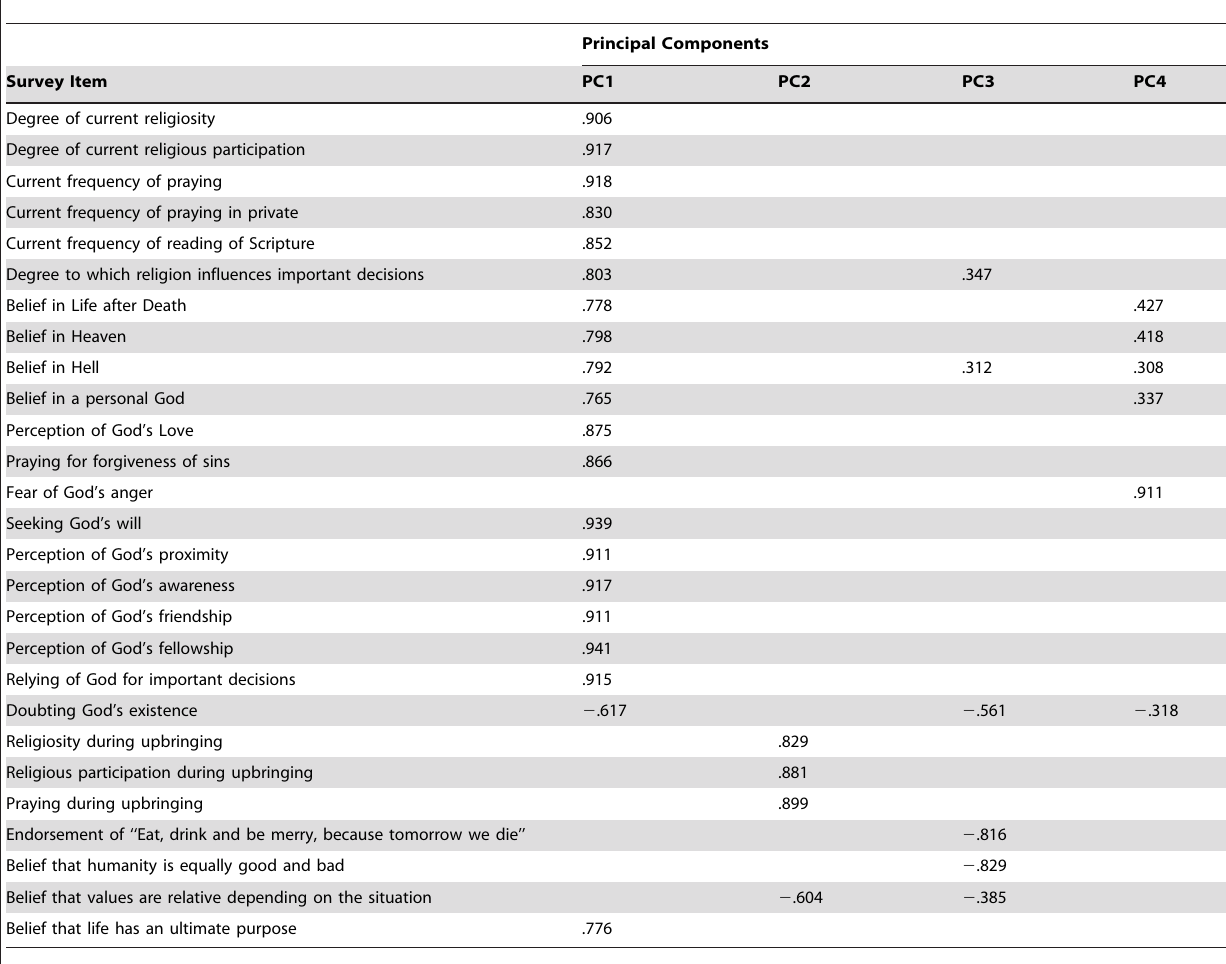
Table 1. The rotated correlation matrix of the original survey items and the four Principal Components